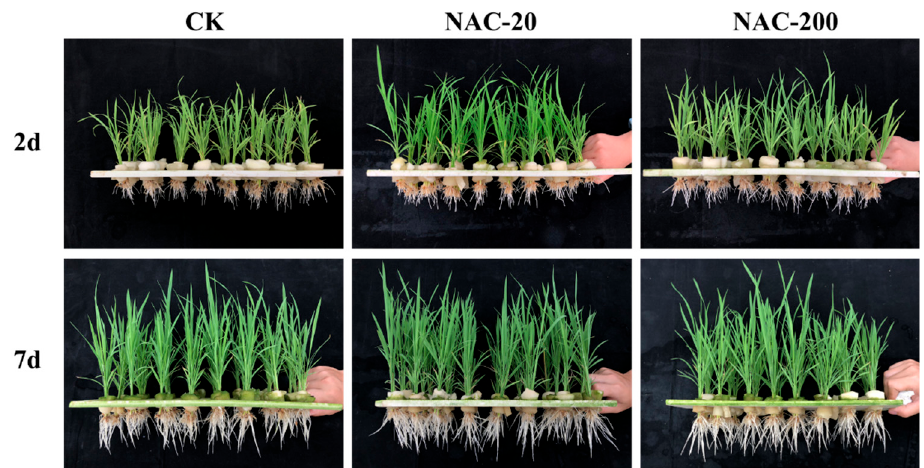
Figure 1. Effects of different concentrations of NAC on seedling growth at the 2 and 7 days after